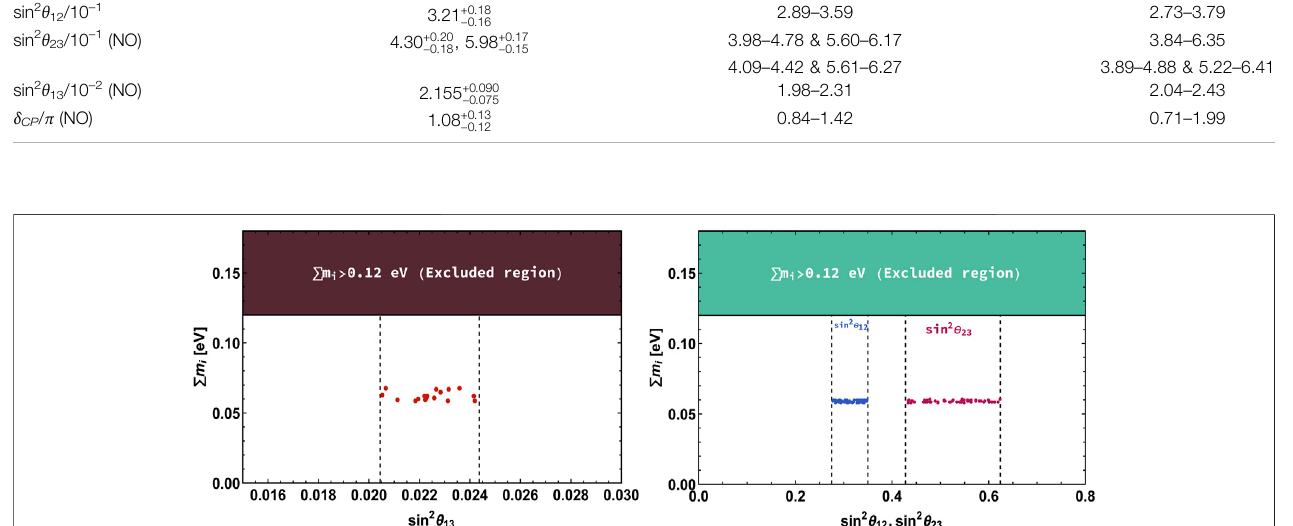
FIGURE 1 | Left (right) panel displays the correlation between sin 2 θ 13 (sin 2 θ 12 and sin 2 θ 23 ) with the sum of active neutrino masses. The vertical lines represent 3 σ allowed ranges of the mixing angles.